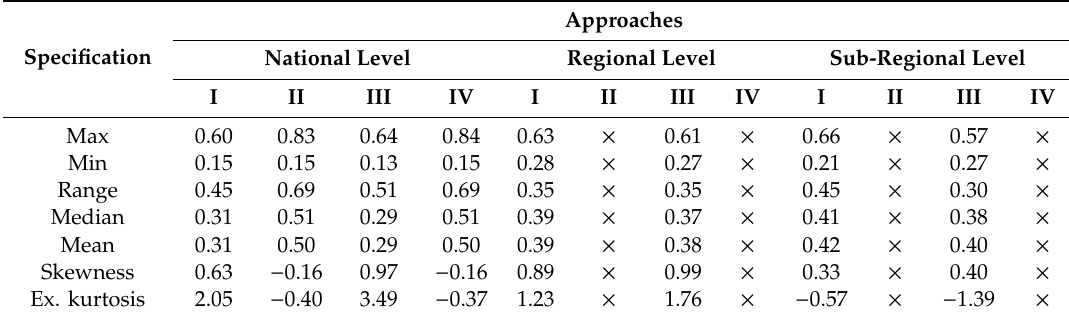
Table 8. Descriptive statistics of the synthetic measures of economic development of districts in Poland in 2017 according to approaches.